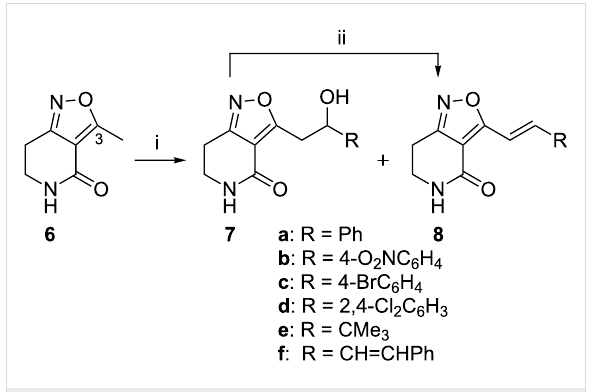
Scheme 1: Aldol reactions of tetrahydroisoxazolopyridone 6 . Reagents: (i) LDA–TMEDA, RCHO, THF, − 20 °C; (ii) toluene, reflux, PTSA.